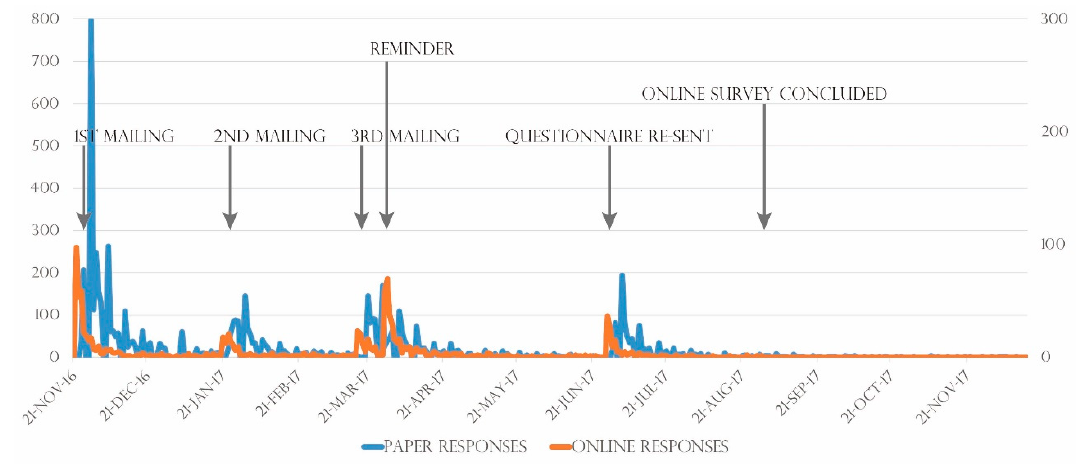
Figure 2. Daily numbers of respondents by response method. Table 1. Characteristics of Pregnancy and Birth Survey 2016 subjects: comparisons by survey method.